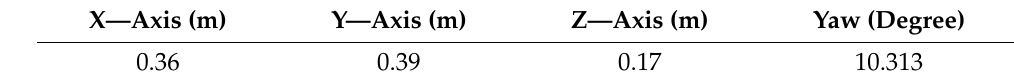
Table 5. RMS errors with MCL [25].